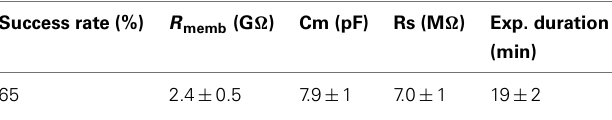
Table 1 | Success rate, cell parameters, and experiment duration for n = 35 HEK cells stably expressing hERG.